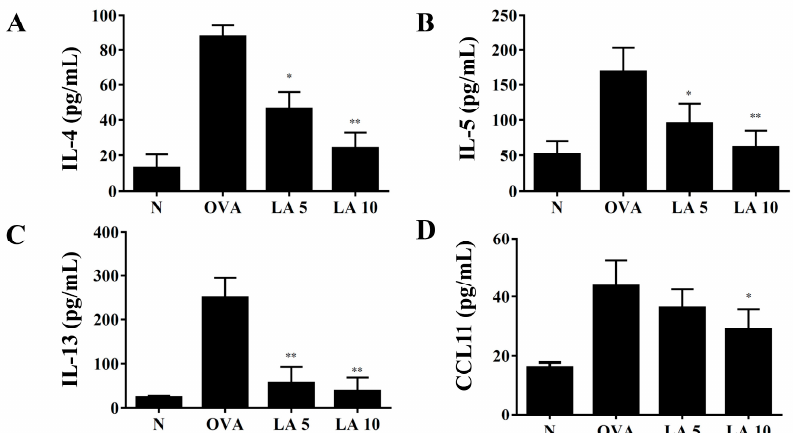
Figure 4. Effects of licochalcone A (LA) on the levels of cytokines and chemokines in BALF. The concentrations of ( A ) IL-4, ( B ) IL-5, ( C ) IL-13, and ( D ) CCL11 in BALF from normal (N) and OVA-stimulated (OVA) mice with or without licochalcone A (LA5-10) treatment were measured by ELISA. Three independent experiments were analyzed, and data were presented as mean ± SEM. * P < 0.05 compared to the OVA control group. ** P < 0.01 compared to the OVA control group.